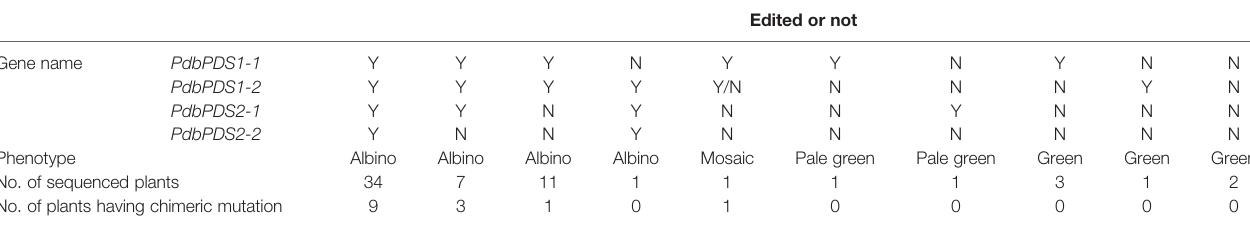
TABLE 2 | Summary of the edited genes and phenotypes of the sequenced transgenic plants.